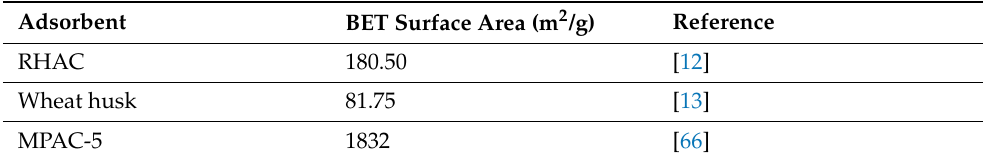
Table 4. BET Surface Area of various adsorbent.